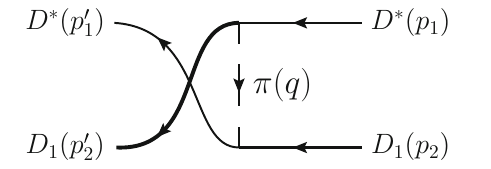
Fig. 1 The cross diagram of the D ∗ ¯ D 1 interaction by the π exchange